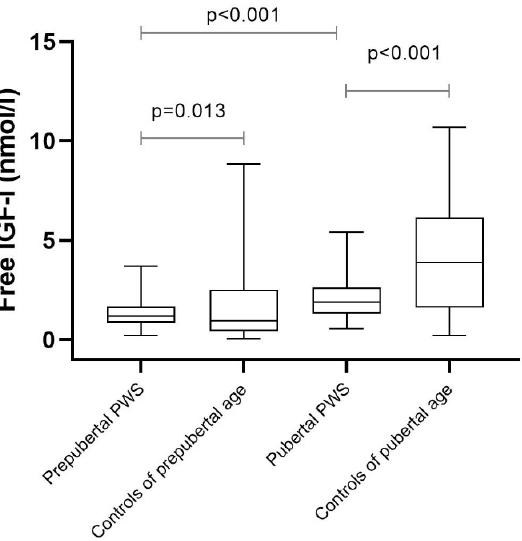
Figure 2. Free IGF-I in GH-treated prepubertal and pubertal children with PWS and healthy controls.